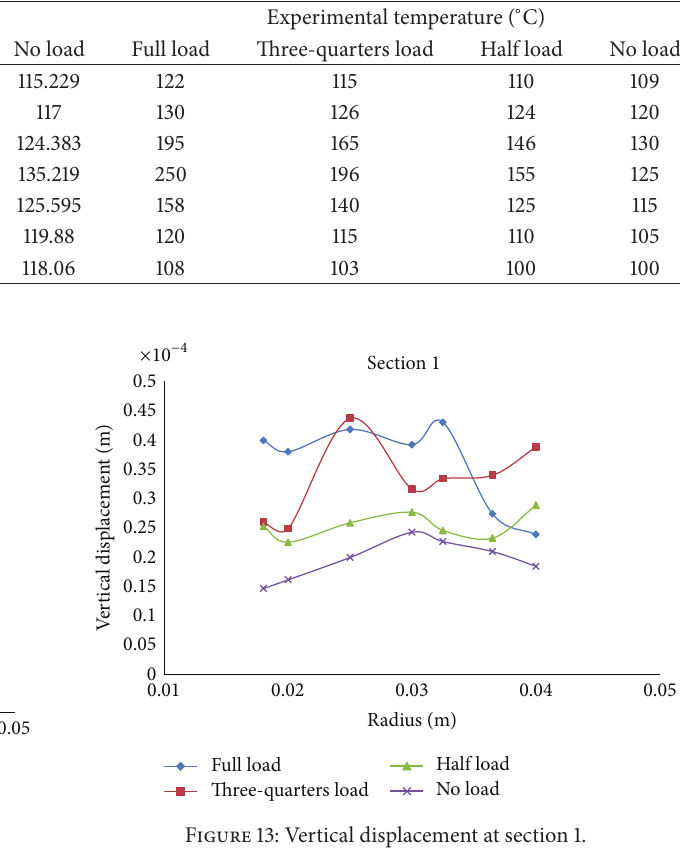
Figure 13: Vertical displacement at section